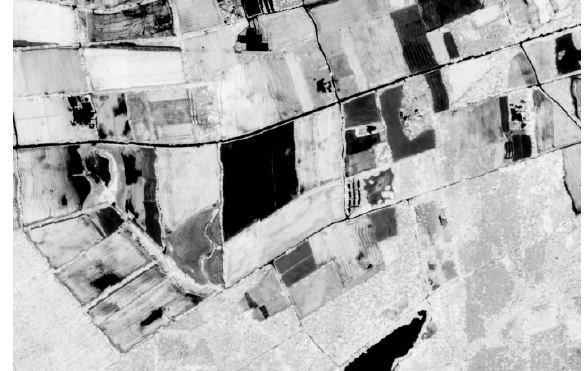
Figure 8. Endmember 4 abundance map. The brighter the pixel, the higher is the percentage of the fourth endmember (general vegetation) in the image.